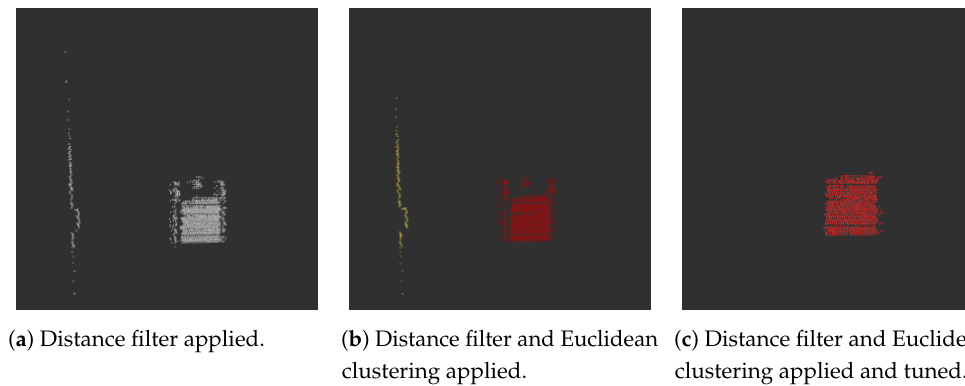
Figure 10. Target detection